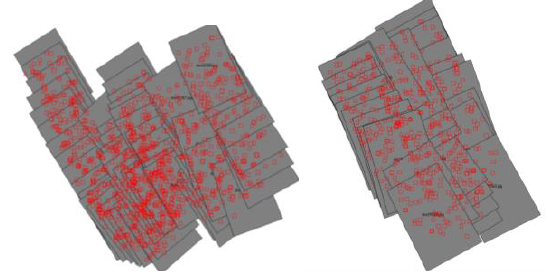
Figure 9 High flight block (left), low flight block (right) Average Flight